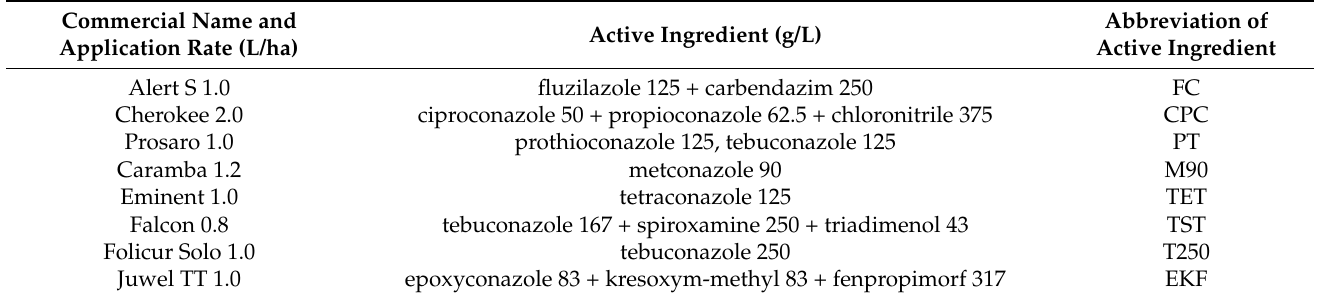
Table 1. Active ingredients of the fungicides and their